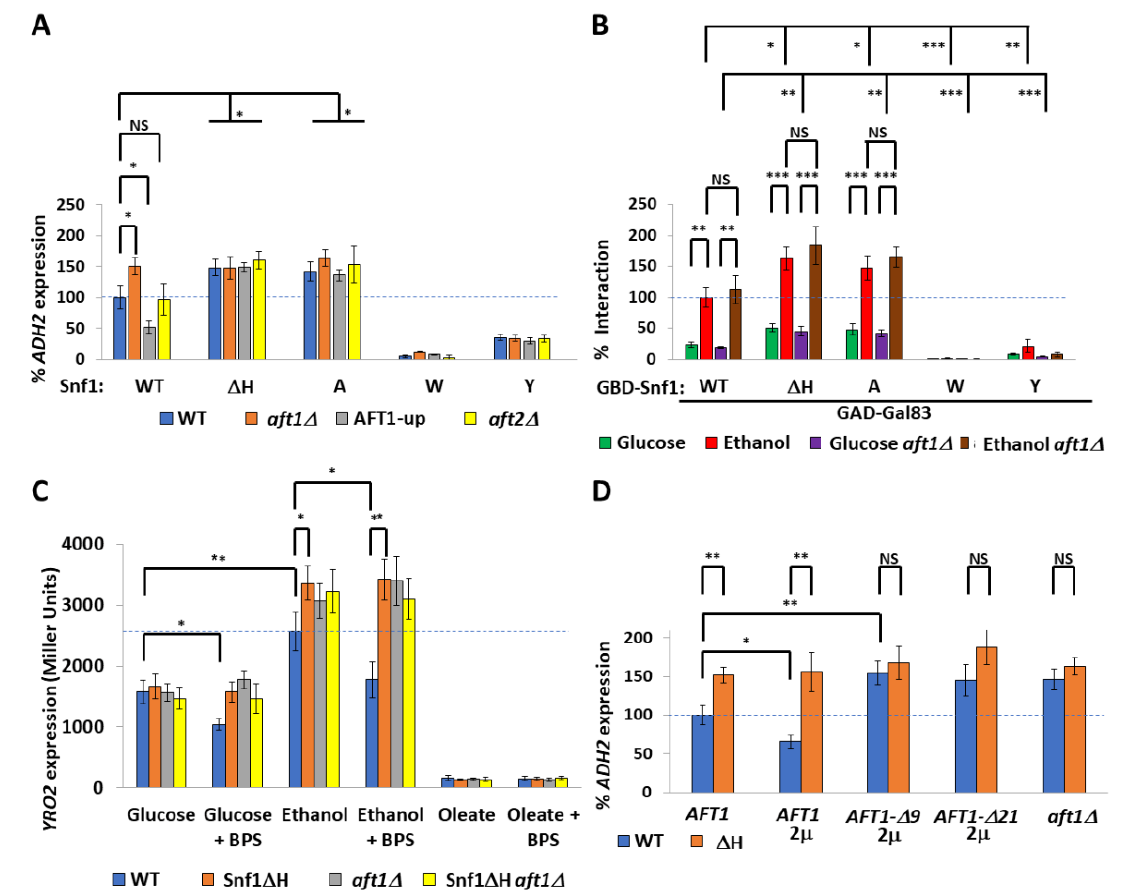
Figure 2. Aft1 inhibits Snf1. ( A ) Rate of prADH2 ::LacZ expression of indicated cells (in a snf1